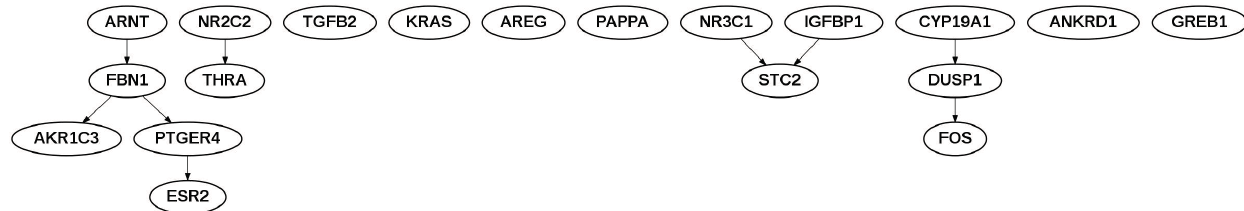
Figure 7. Identification of the maximum likelihood structure of PCBs associated genes in breast neoplasm using the Bayesian network analysis on the Cancer Genome Atlas (TCGA) Research Network